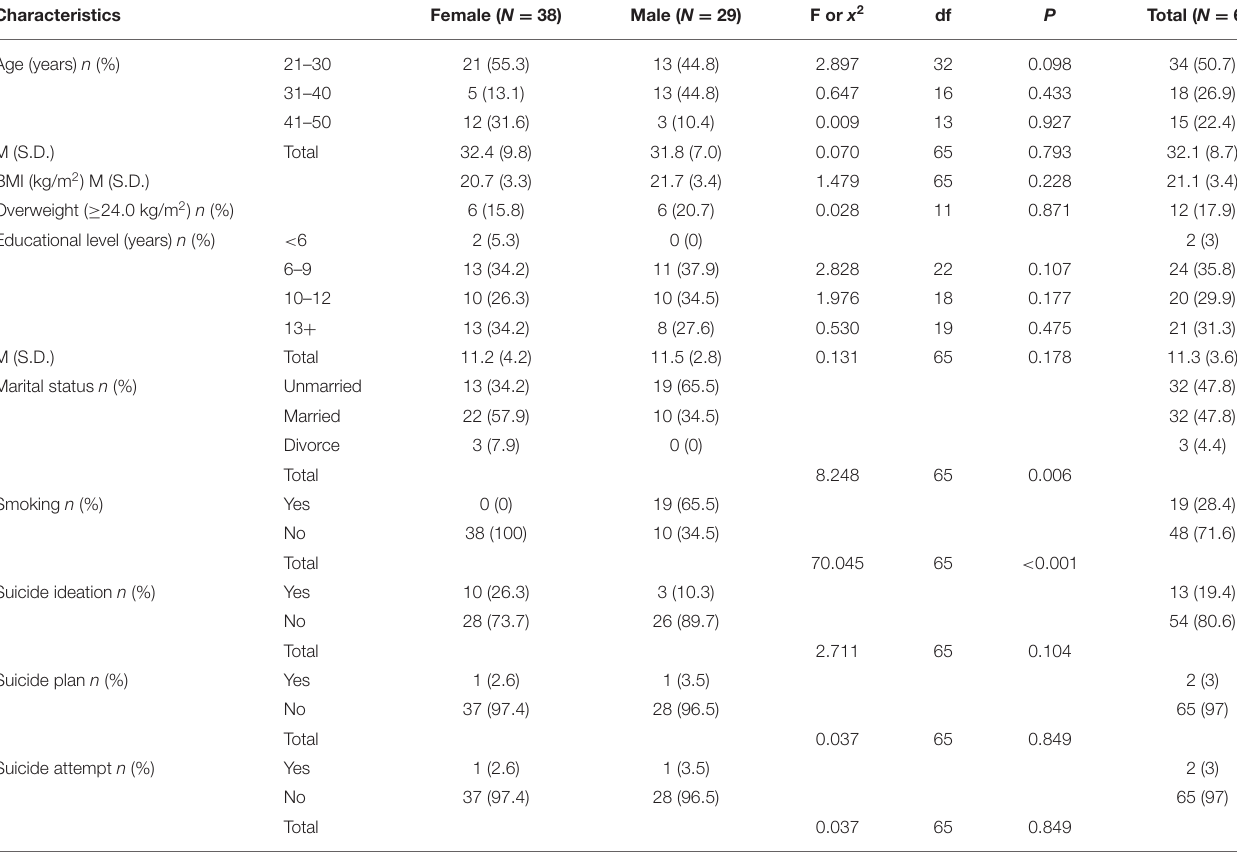
TABLE 1 | Distribution of participants by demographics characteristics (Chengdu, China, 2018) by sex. Characteristics